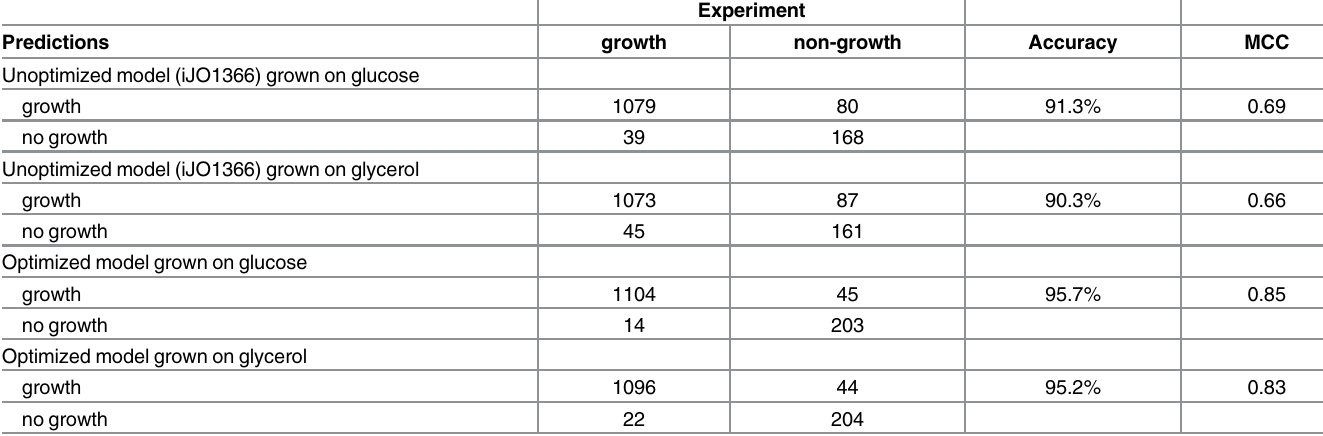
Table 3. Comparison of experimental and predicted viability for 1366 E . coli gene knockouts on two different minimal